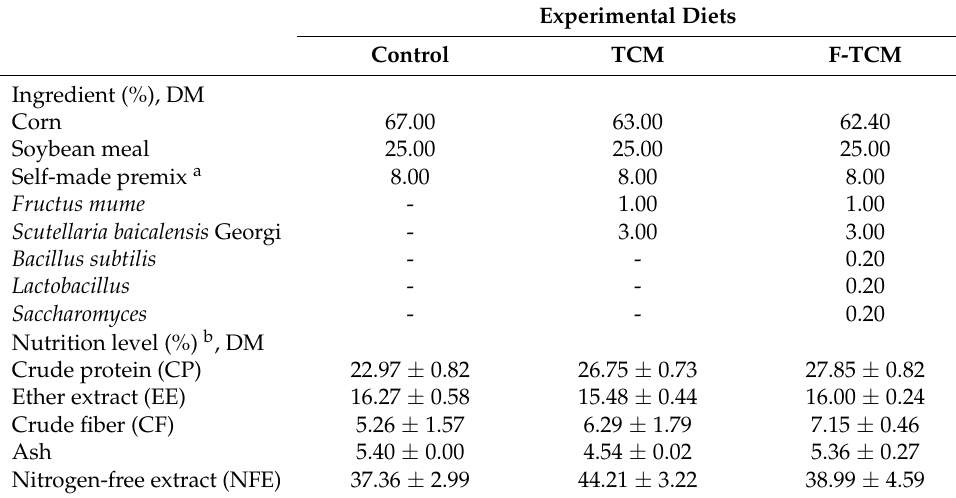
Table 2. Composition and nutrient levels of the experimental